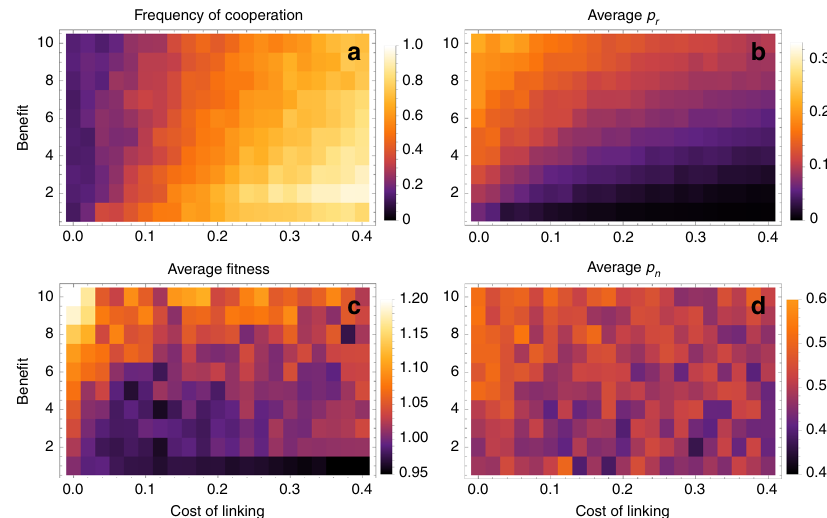
Fig. 4 Mean frequency of cooperation ( a ), p r ( b ), p n ( d ), and average fi tness ( c ) over ten replicate simulations, averaged across time, as a function of the bene fi t from cooperation and the cost of linking. Each simulation was initiated with p r = 0.0001, p n = 0.5, frequency of cooperation at 0.5, and run for 10 5 generations (10 7 time steps). Averages over the fi nal 8 × 10 4 generations (sampled once each generation) are shown. Note that these simulations are run over longer time-periods than the ones in Fig. 1 to give the system time to explore the larger (and continuous) state space that includes the evolving linking traits. Parameter values are N = 100, C = 0.5, D = 0, μ = μ l = 0.001, σ n = σ r = 0.01, δ =